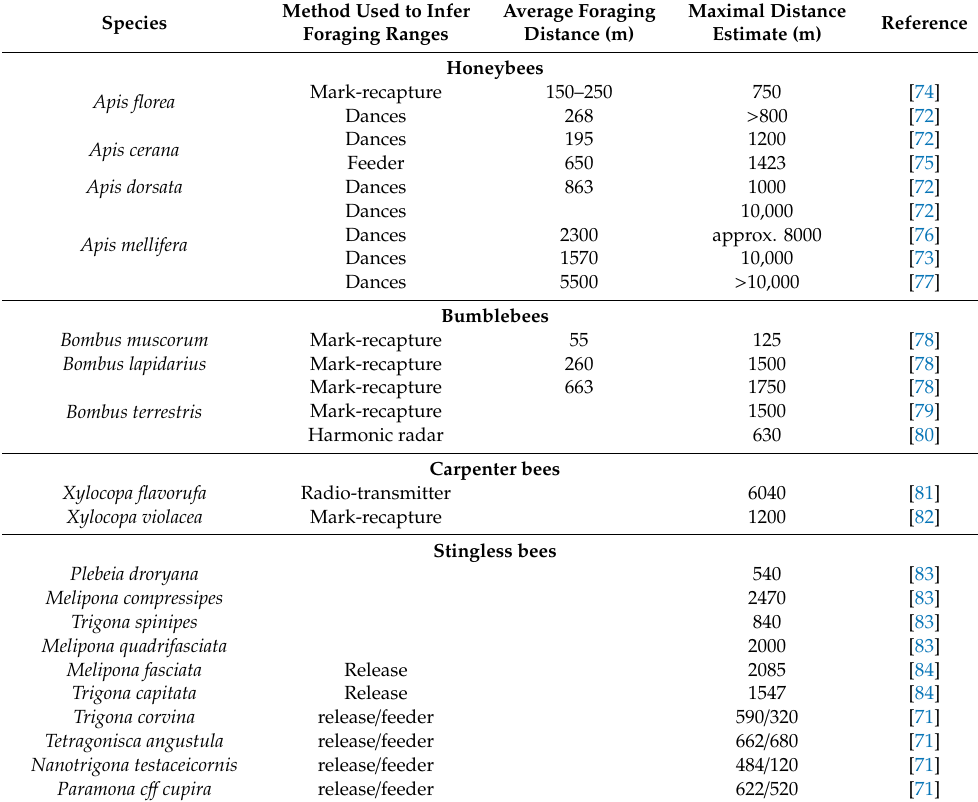
Table 4. Foraging distances estimated for di ff erent Apidae species. For more information on methods, please see the